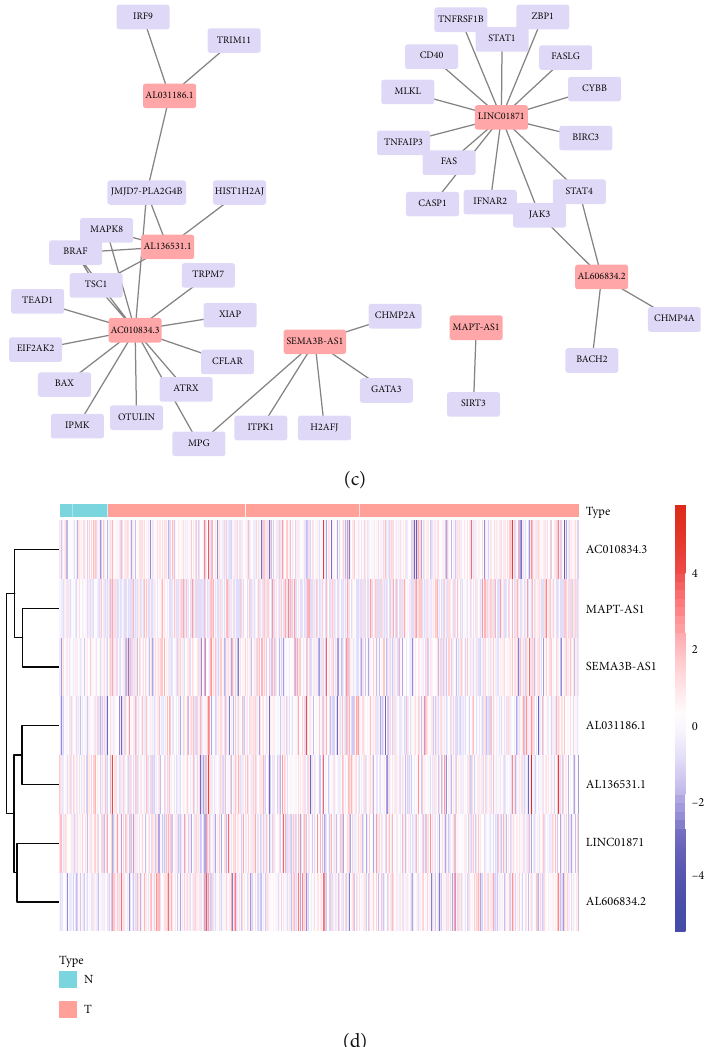
Figure 1: Identi fi cation of necroptosis-related lncRNAs with predictive prognostic values in BRCA. (a) The forest plot shows the HR (95% CI) and P values ( P < 0 : 05 ) of selected lncRNAs determined using univariate analysis. (b) The Sankey diagram shows the association between lncRNAs, mRNA, and risk types. (c) lncRNA-mRNA coexpression network of necroptosis-associated lncRNAs and corresponding genes. (d) Expression levels of 7 lncRNAs associated with necroptosis in tumor tissue and normal